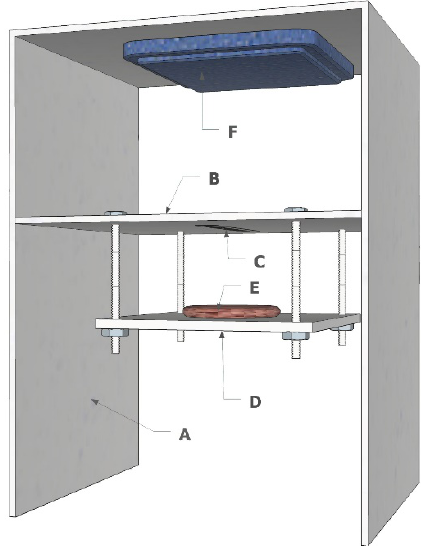
Figure 2. UHF test bench: ( A ) low-density polystyrene box, ( B ) central fixed shelf, ( C ) UHF tag, ( D ) adjustable platform, ( E ) meat sample and ( F ) UHF panel antenna.